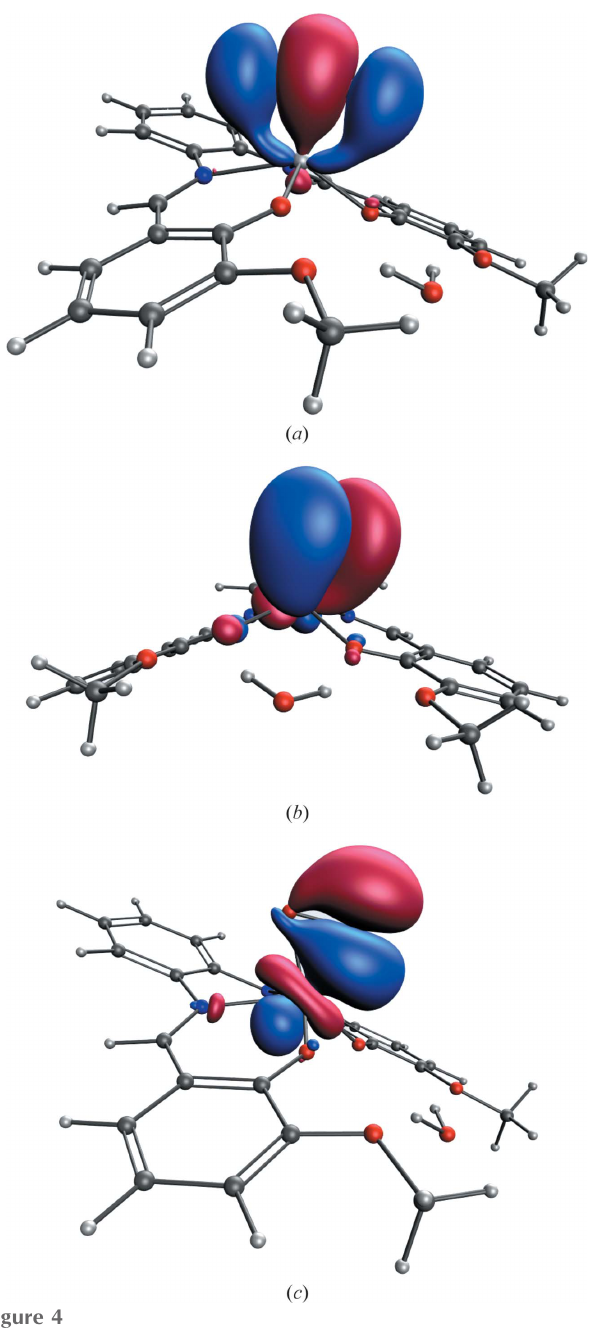
Figure 4 ( a ) (cid:7) O(1)—O(2)-like DAFH eigenvector (1.95); ( b ) p y O(1)-like DAFH eigenvector (1.82); ( c ) p z O(1)-like DAFH eigenvector (1.64) (DAFH eigenvalues are shown in